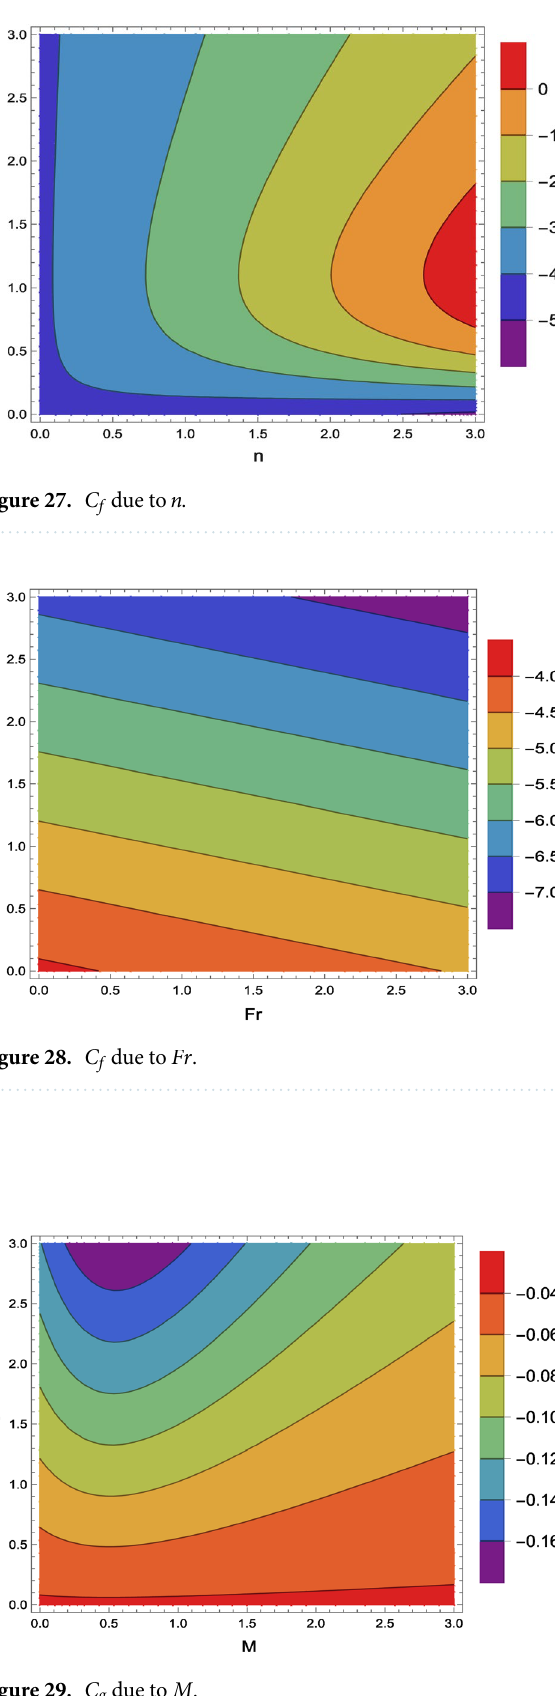
Figure 29. C g due to M